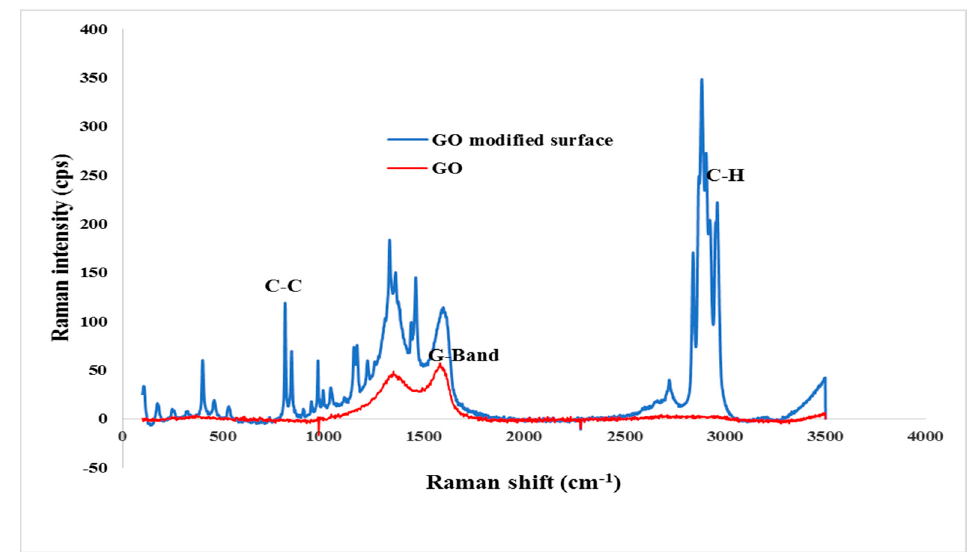
Figure 3. Raman spectra of the permeate surface of GOIM-P.